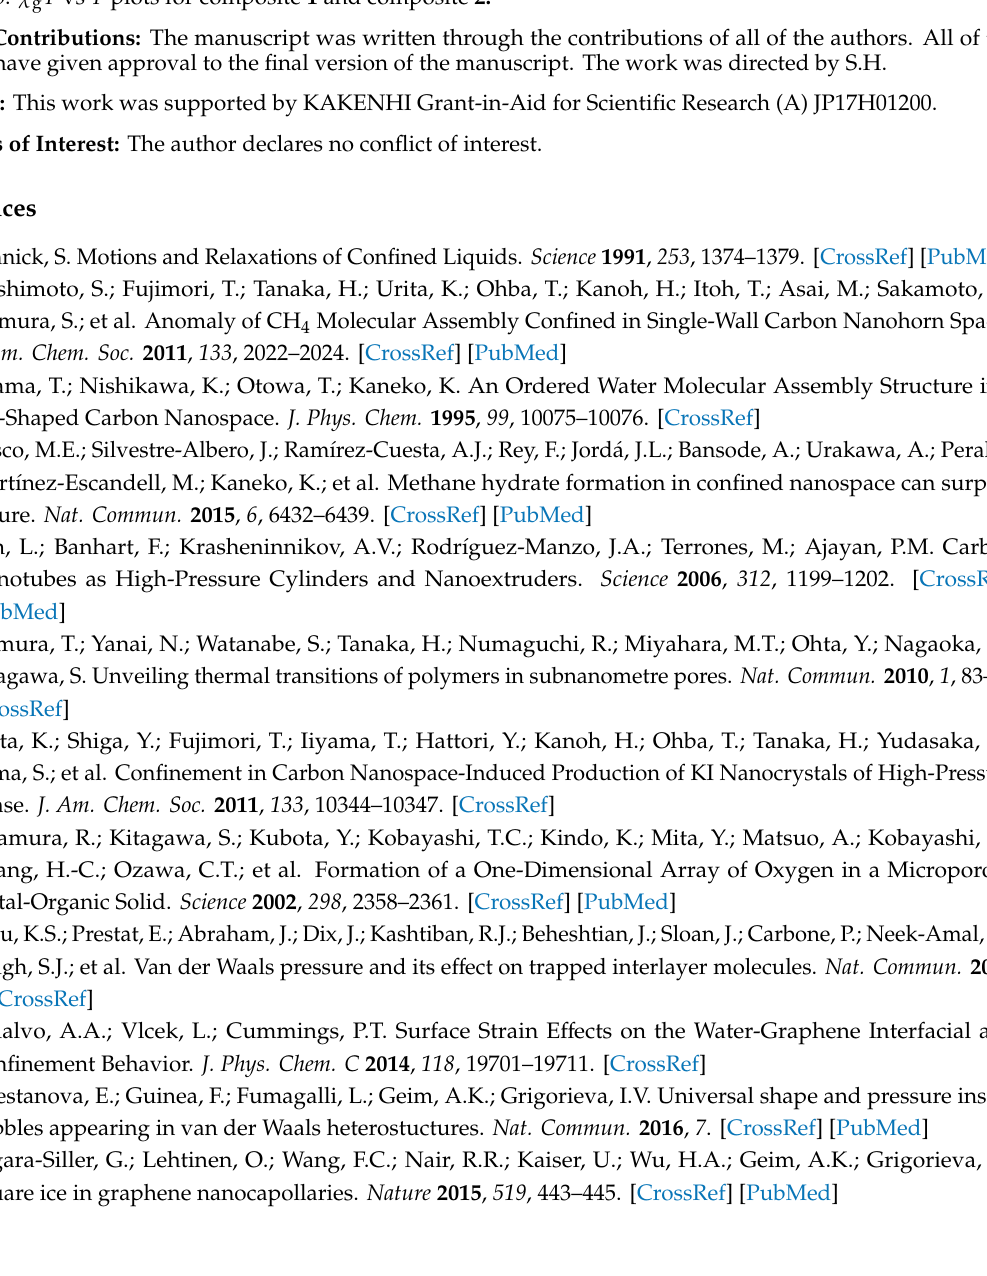
Figure S1: I–V curves for 1 and 2 . Figure S2: SEM image of [Fe(Htrz) 2 (trz)](BF 4 ) NRs. Figure S3: FT-IR spectra for [Fe(Htrz) 2 (trz)](BF 4 ) NRs, composite 1, and composite 2 . Figure S4: χ m T vs. T plot for [Fe(Htrz) 2 (trz)](BF 4 ) NRs. Figure S5: χ g T vs T plots for composite 1 and composite